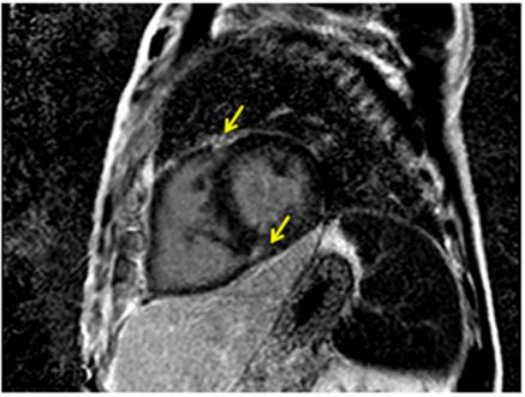
Figure 7. CMR imaging of a PH patient showing the typical septal junctional pattern of late gadolinium enhancement (yellow